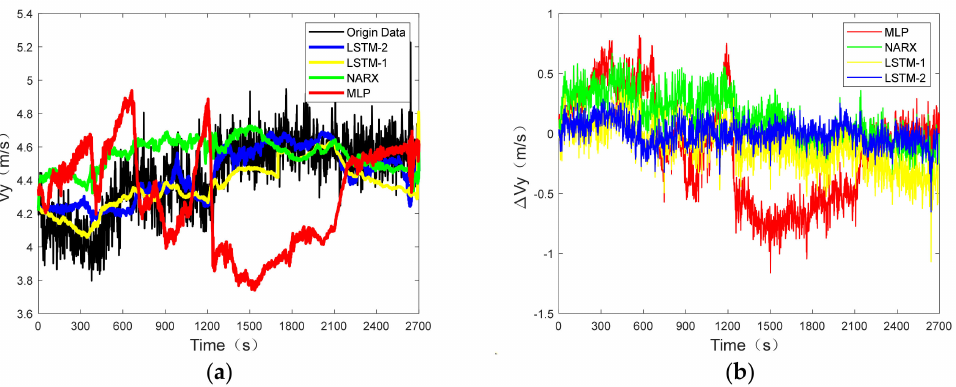
Figure 11. Prediction results of north velocity: ( a ) Comparison of actual value and the predicted velocity in the north; ( b ) The errors of actual value and the predicted velocity in the north for different